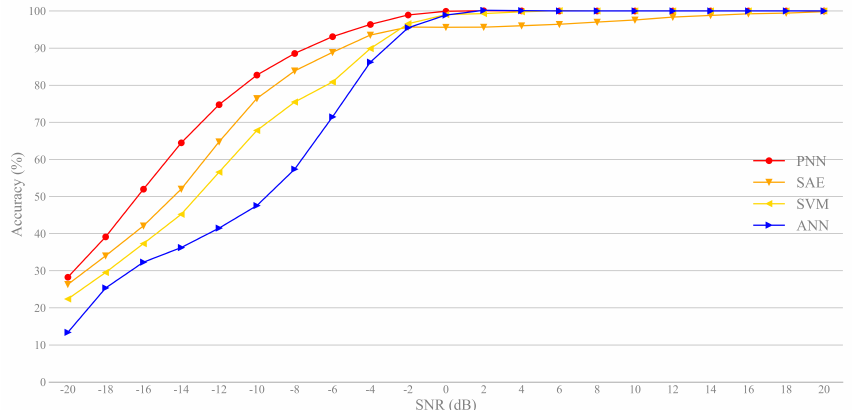
Figure 9. Classification accuracy vs. SNR for each signals using FWS approach.